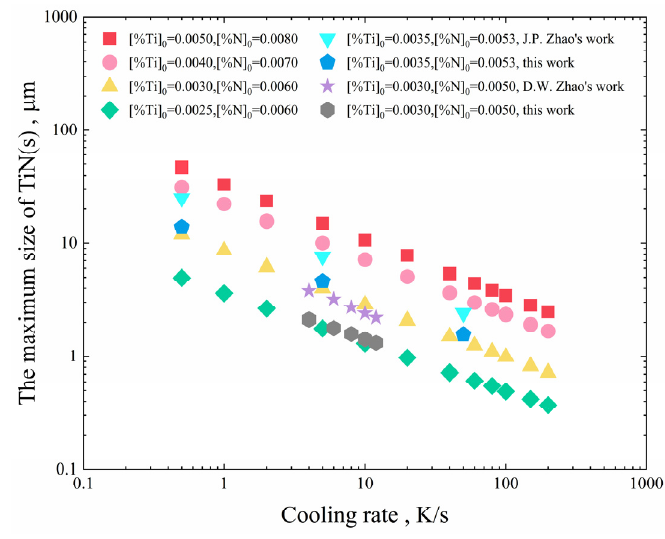
ff ect of cooling rate on the maximum size of TiN Figure 11. The effect of cooling rate on the maximum size of TiN inclusions. Figure 11. The e